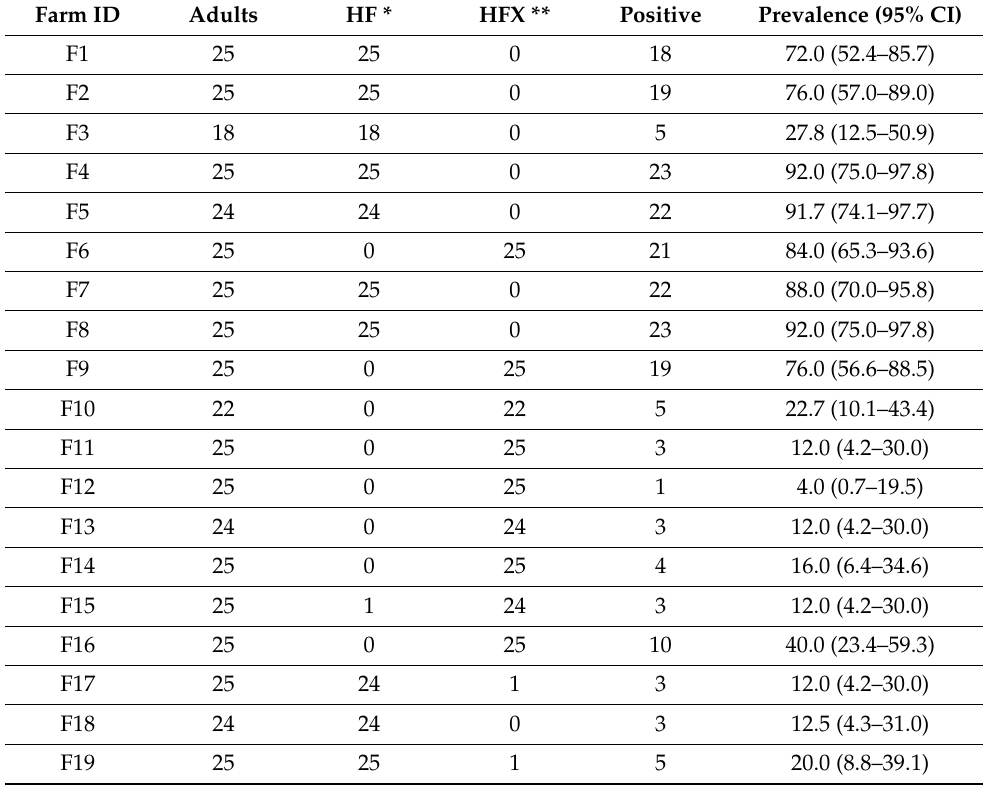
Table 1. Seroprevalence of Mycoplasma bovis exposures in adult animals in different farms in the southwest region of Western